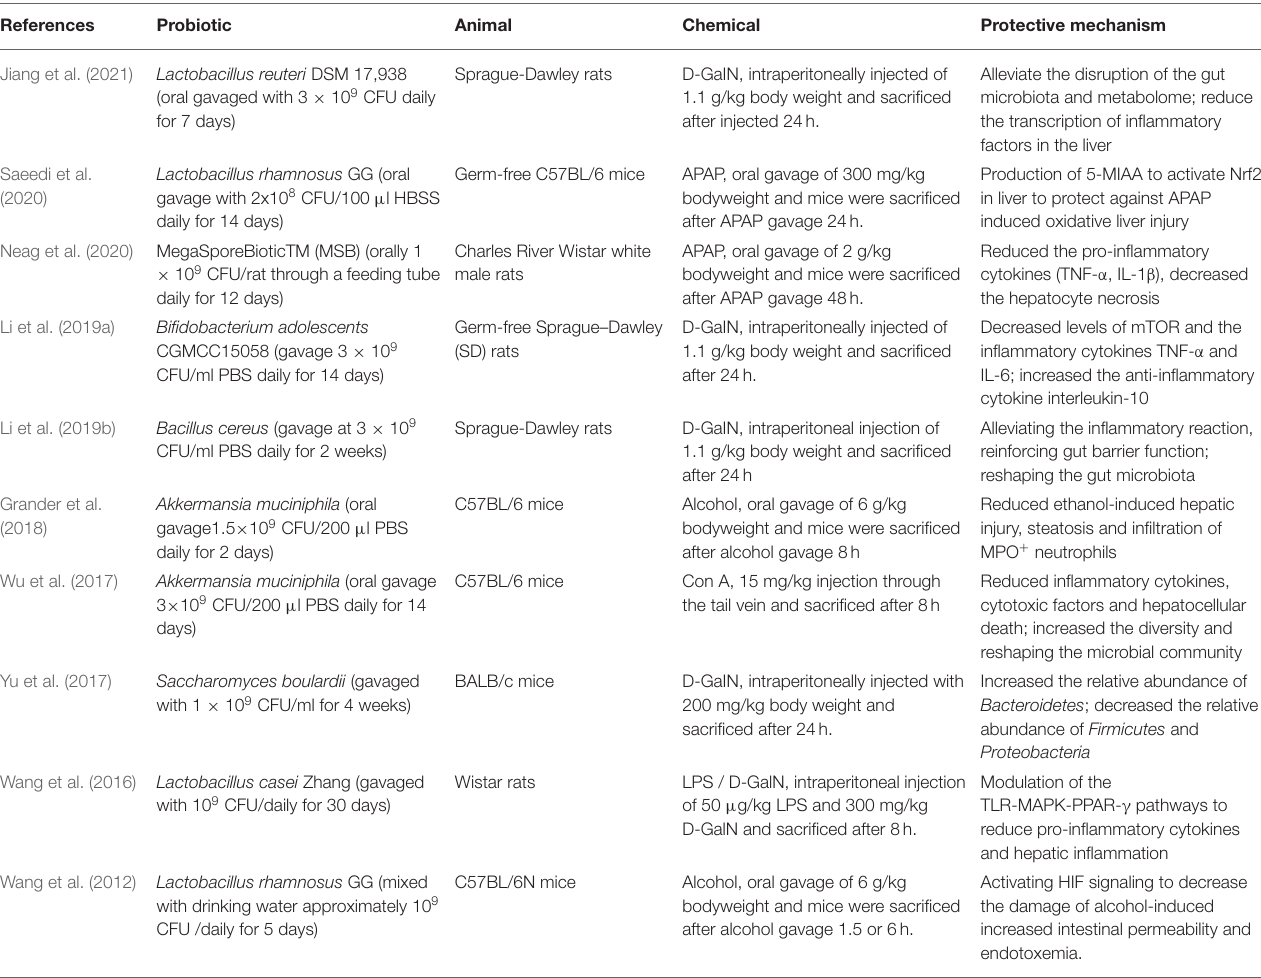
TABLE 1 | Application of probiotics in chemical-induced acute liver injury